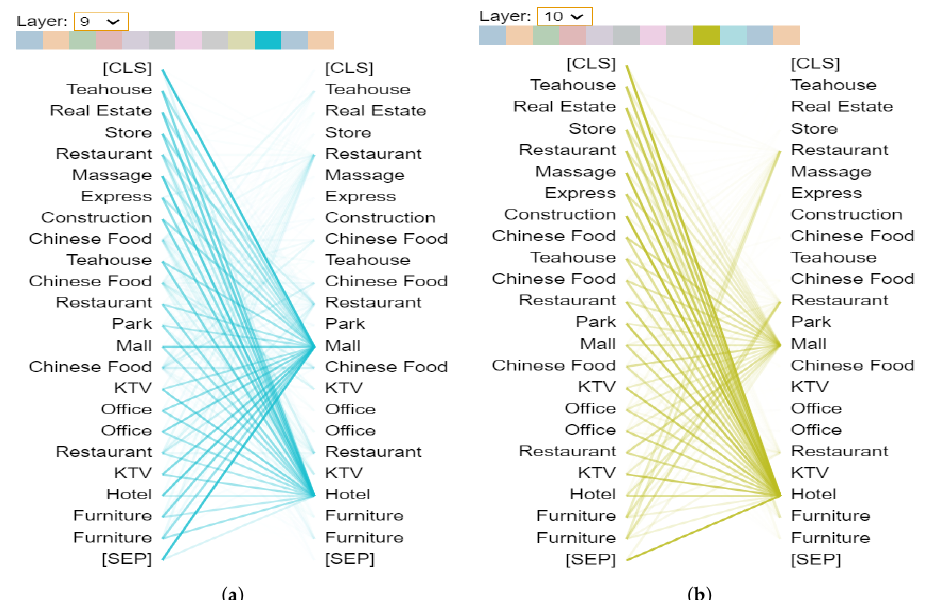
Figure 18. Two specific attention heads in GeoBERT-ShortestPath. In both figures, tokens “Mall” and “Hotel” strongly connect with all other tokens. We define this kind of token as the “Anchor POIs” in a grid. Anchor POIs play essential roles in a grid and to some extent can represent certain attributes of the whole grid: ( a ) Layer 9, Head 9; ( b ) Layer 10, Head